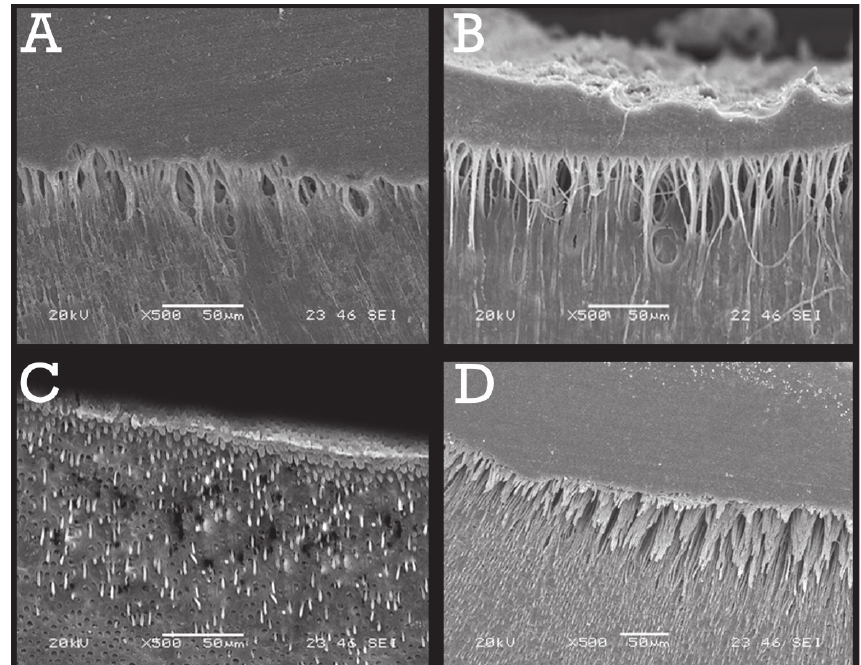
Figure 2- Scanning electron microscopy images (SEM) (magnification 500x, bar 50 μm) from a representative push-out tested on dentin slice specimens: (A) Experimental Group 1; and (B) Experimental Group 2 showed an evident hybrid layer with long resin tags; (C) One Step Plus/Ethanol/Experimental Luting Agent resulted in the formation of short and discrete resin tags; (D) One Step Plus as the control group using the regular wet bonding technique demonstrated the formation